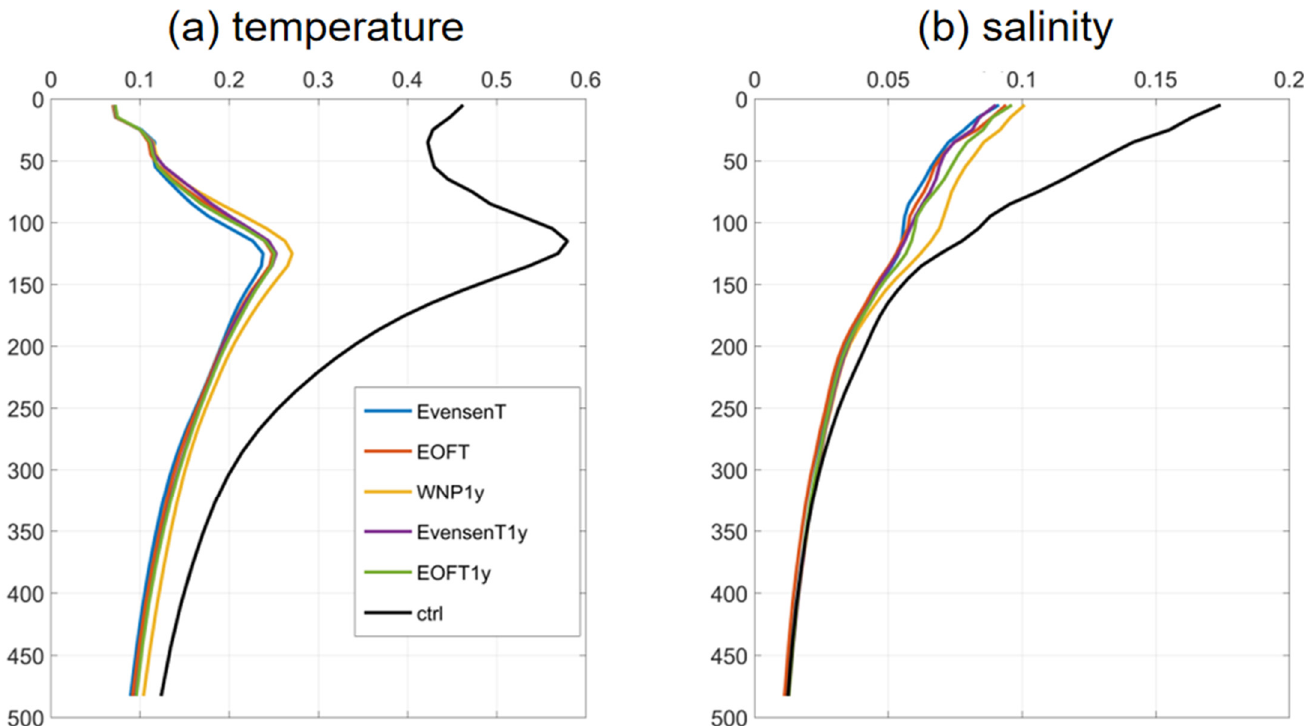
Figure 12 . Vertical distribution (0–500 m) of the RMSE for temperature (a) and salinity (b) models Figure 12. Vertical distribution (0–500 m) of the RMSE for temperature ( a ) and salinity ( b ) models for for six experiments averaged globally compared to “truth”. six experiments averaged globally compared to